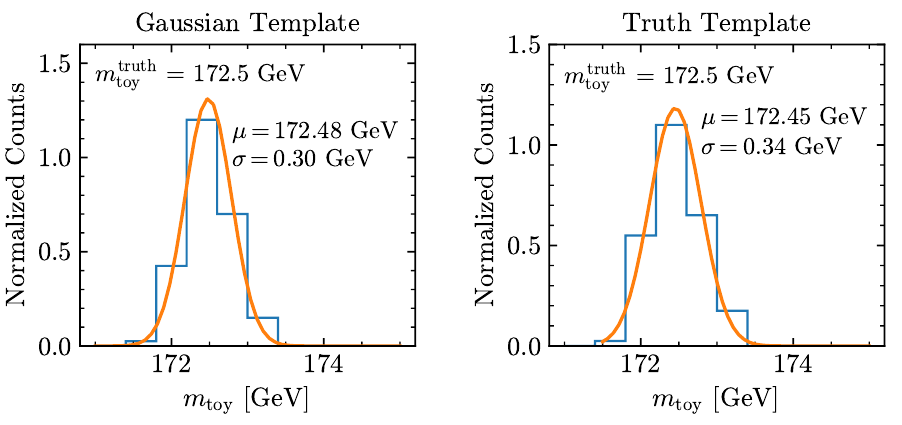
Figure 6 . The left panel shows the value extracted from 100 independent data sets of m 172.5 GeV assuming this Gaussian based template while the right panel shows the same data with the template from eq. (2.3). The bias and uncertainty with the simpler model are smaller than when we used the truth